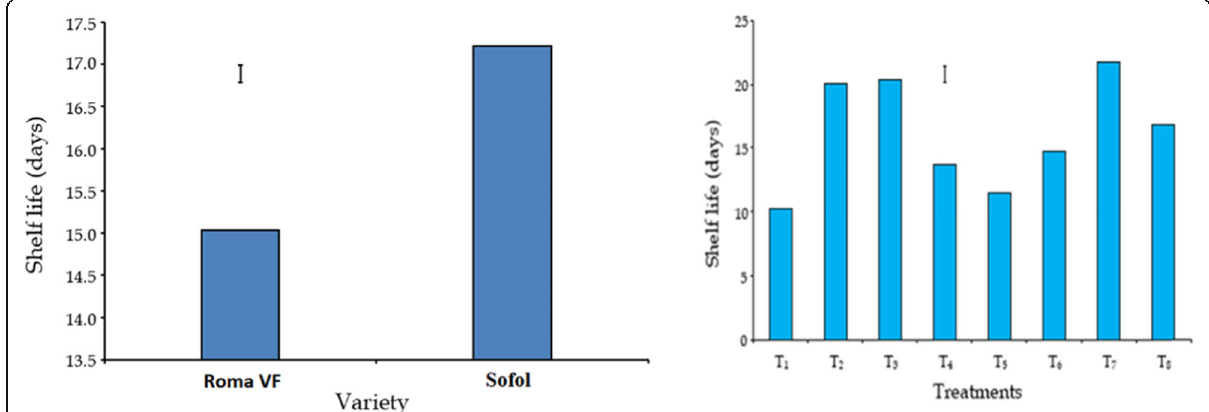
Fig. 5 a Main effects of variety on the shelf life of tomato during storage and ripening, vertical bar indicates LSD value at the 1% level